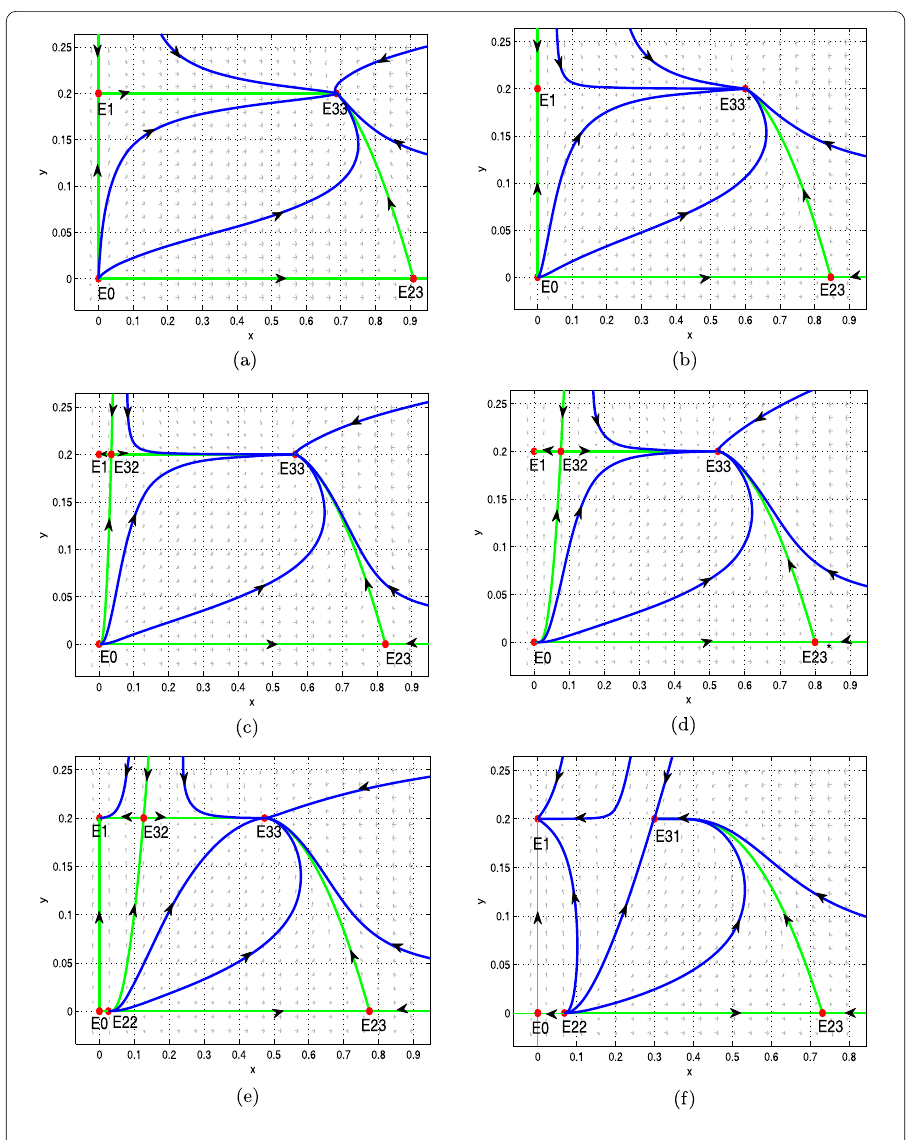
Figure 1 ( a ) Dynamic behaviors of system (1.3), the parameters ( α , β , γ , δ ) = (0.1,0.5,0.2,0.4). ( b ) Dynamic behaviors of system (1.3), the parameters ( α , β , γ , δ ) = (0.16,0.5,0.2,0.4). ( c ) Dynamic behaviors of system (1.3), the parameters ( α , β , γ , δ ) = (0.18,0.5,0.2,0.4). ( d ) Dynamic behaviors of system (1.3), the parameters ( α , β , γ , δ ) = (0.2,0.5,0.2,0.4). ( e ) Dynamic behaviors of system (1.3), the parameters ( α , β , γ , δ ) = (0.22,0.5,0.2,0.4). ( f ) Dynamic behaviors of system (1.3), the parameters ( α , β , γ , δ ) = (0.25,0.5,0.2,0.4). ( g ) Dynamic behaviors of system (1.3), the parameters ( α , β , γ , δ ) = (0.3,0.5,0.2,0.4). ( h ) Dynamic behaviors of system (1.3), the parameters ( α , β , γ , δ ) = (0.36,0.5,0.2,0.4). ( i ) Dynamic behaviors of system (1.3), the parameters ( α , β , γ , δ ) =